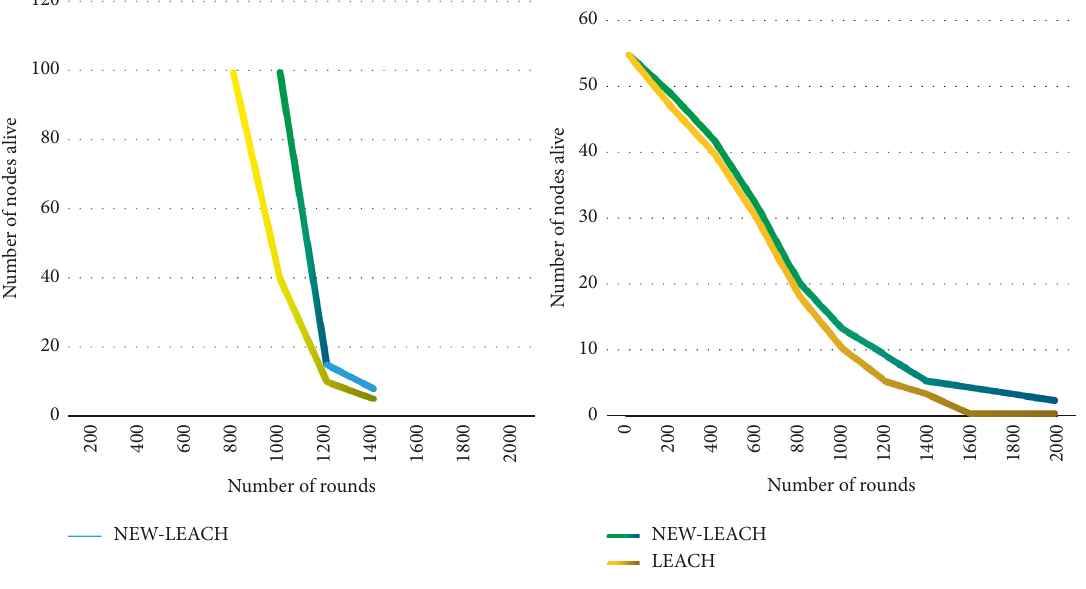
Figure 13: Network nodes and residual energy results.